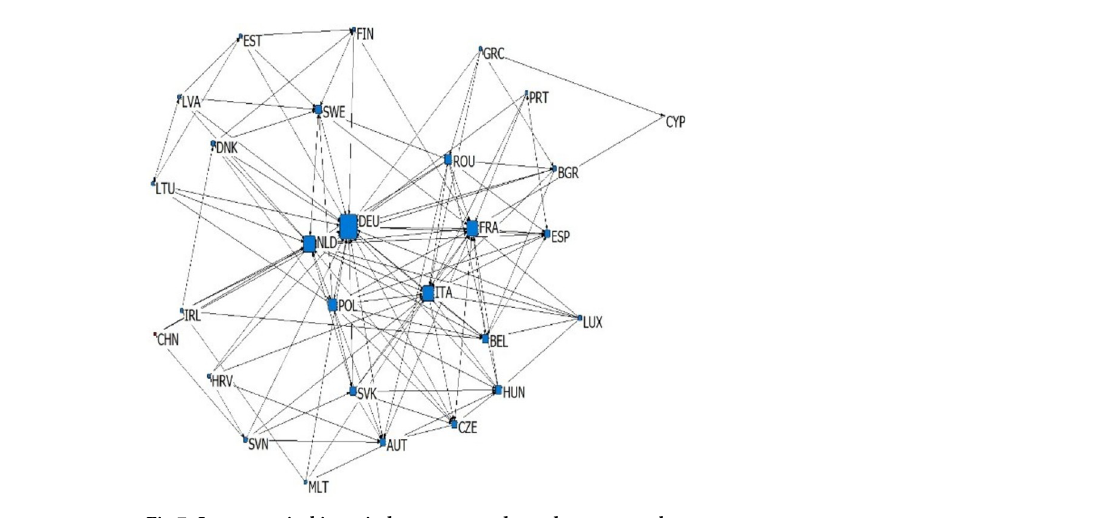
Fig 7. Lower vertical intra industry export dependence network.